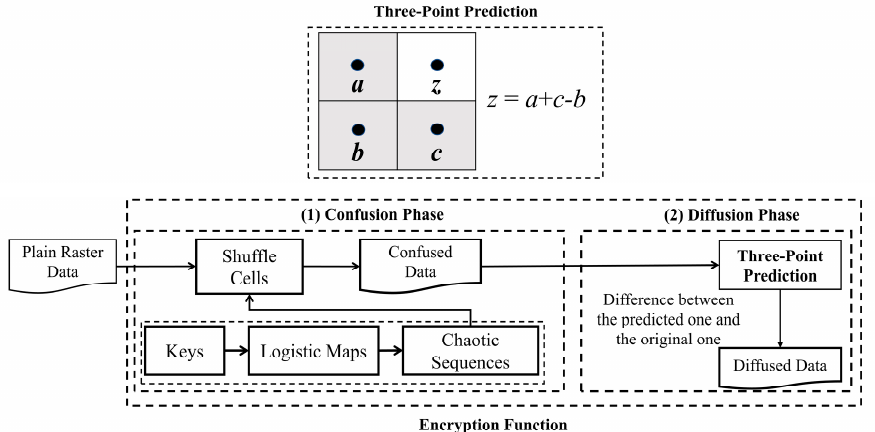
Figure 4. The proposed encryption